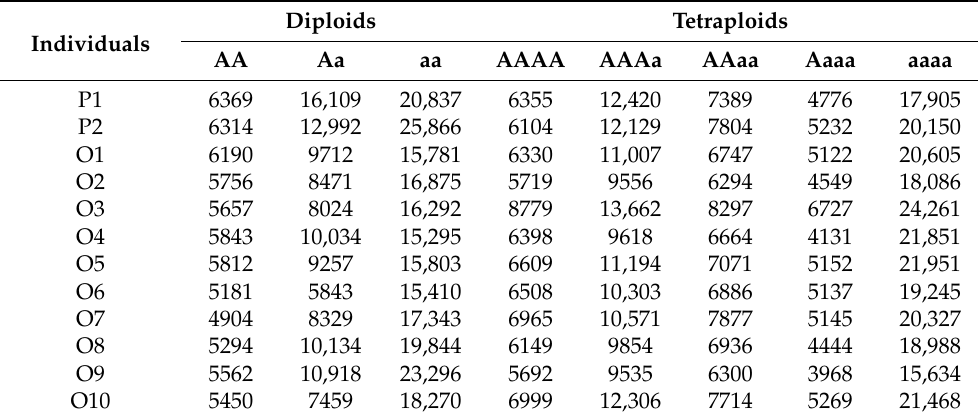
Table 2. The number of polymorphic markers screened from the RAD-seq datasets of diploid and tetraploid parental strains (P1 and P2) and 10 offspring individuals (O1, O2, . . . ,